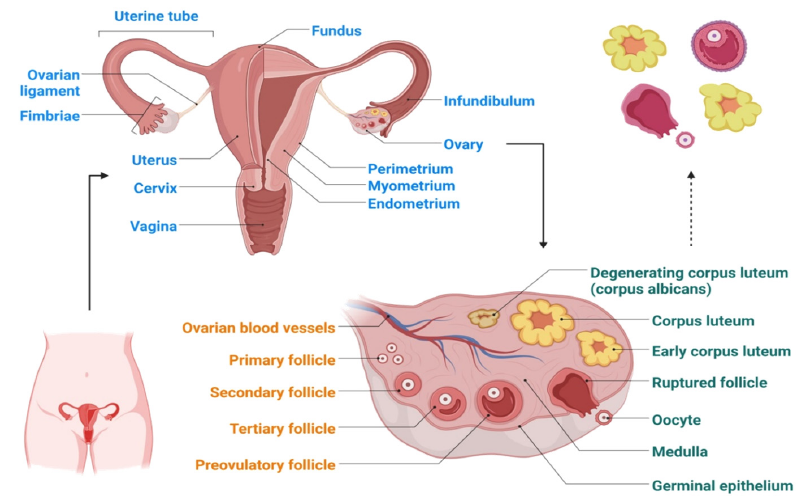
Figure 1. Schematic representation of the ovary structure.